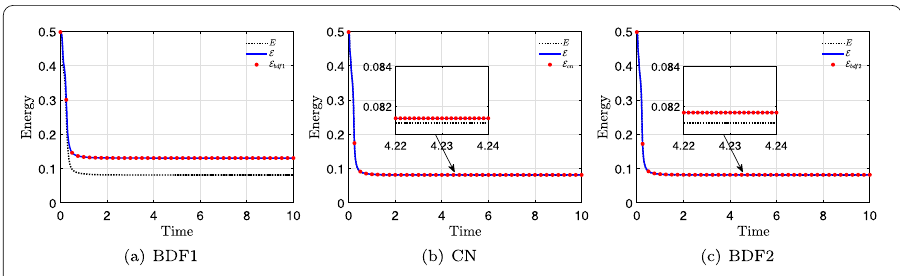
Figure 1 Evolution of energy E defined in (2.2), pseudo energy E defined in (3.5), and modified discrete energies E bdf 1 , E cn , and E bdf 2 , which are calculated by BDF1, CN, and BDF2, respectively. The parameters are ε